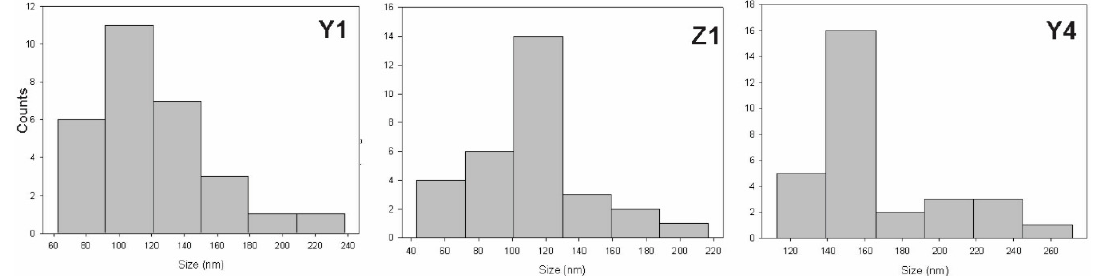
Figure 9. Size distribution for the ZnO prepared under different conditions.